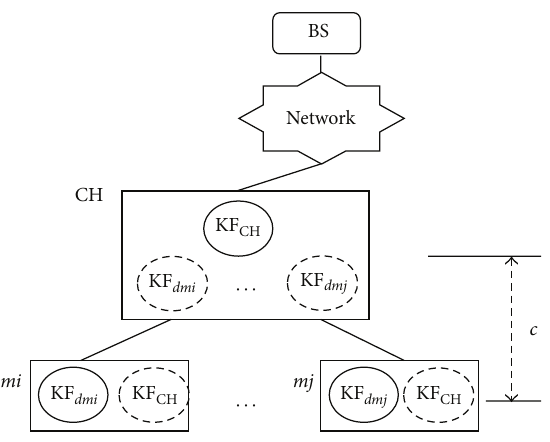
Figure 3: An architecture of a